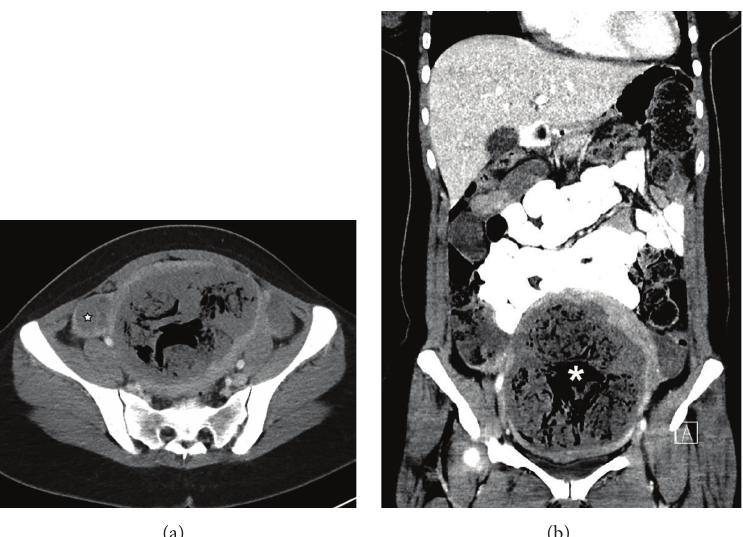
Figure 3: Pelvic CT performed on postprocedure day #26. Axial image (a), at the level of the ovaries (star), and (b) coronal image of the uterus show a large amount of intrauterine air (asterisk), including nonlinear, extravascular air, raising the suspicion of pyomyoma in the proper clinical setting. Patient also had unexpected small bilateral pleural effusions and moderately sized pericardial effusion (not